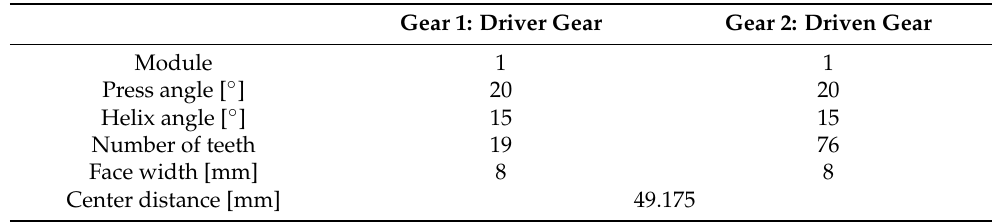
Table 1. Specifications of the gears.